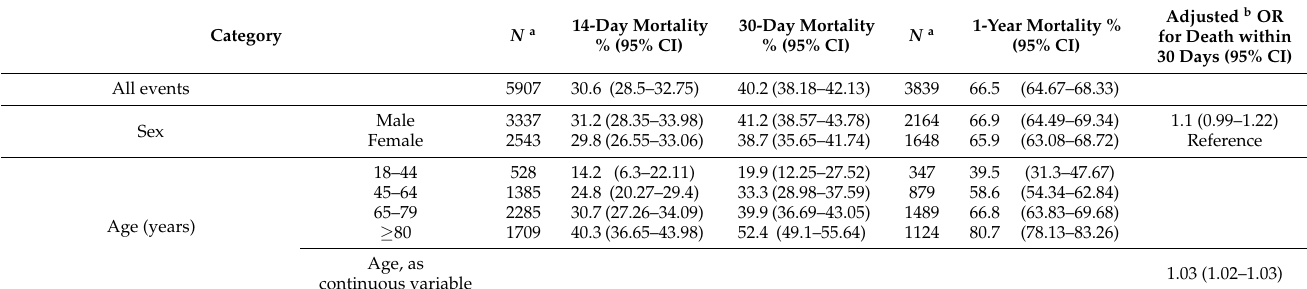
Figure 4. Distribution of sentinel organisms and percentage of antimicrobial-resistant isolates a , by day of hospital-onset bloodstream infection (HO-BSI) onset. a Defined as resistance to key antimicrobial agents: penicillin resistance in S. pneumoniae ; oxacillin or cefoxitin resistance in S. aureus ; vancomycin or teicoplanin resistance in E. faecalis and E. faecium ; extended-spectrum cephalosporin (third and fourth generation) resistance in E. coli and K. pneumonia and non-susceptibility to imipenem or meropenem in E. coli , K. pneumoniae , A. baumannii and P. aeruginosa .